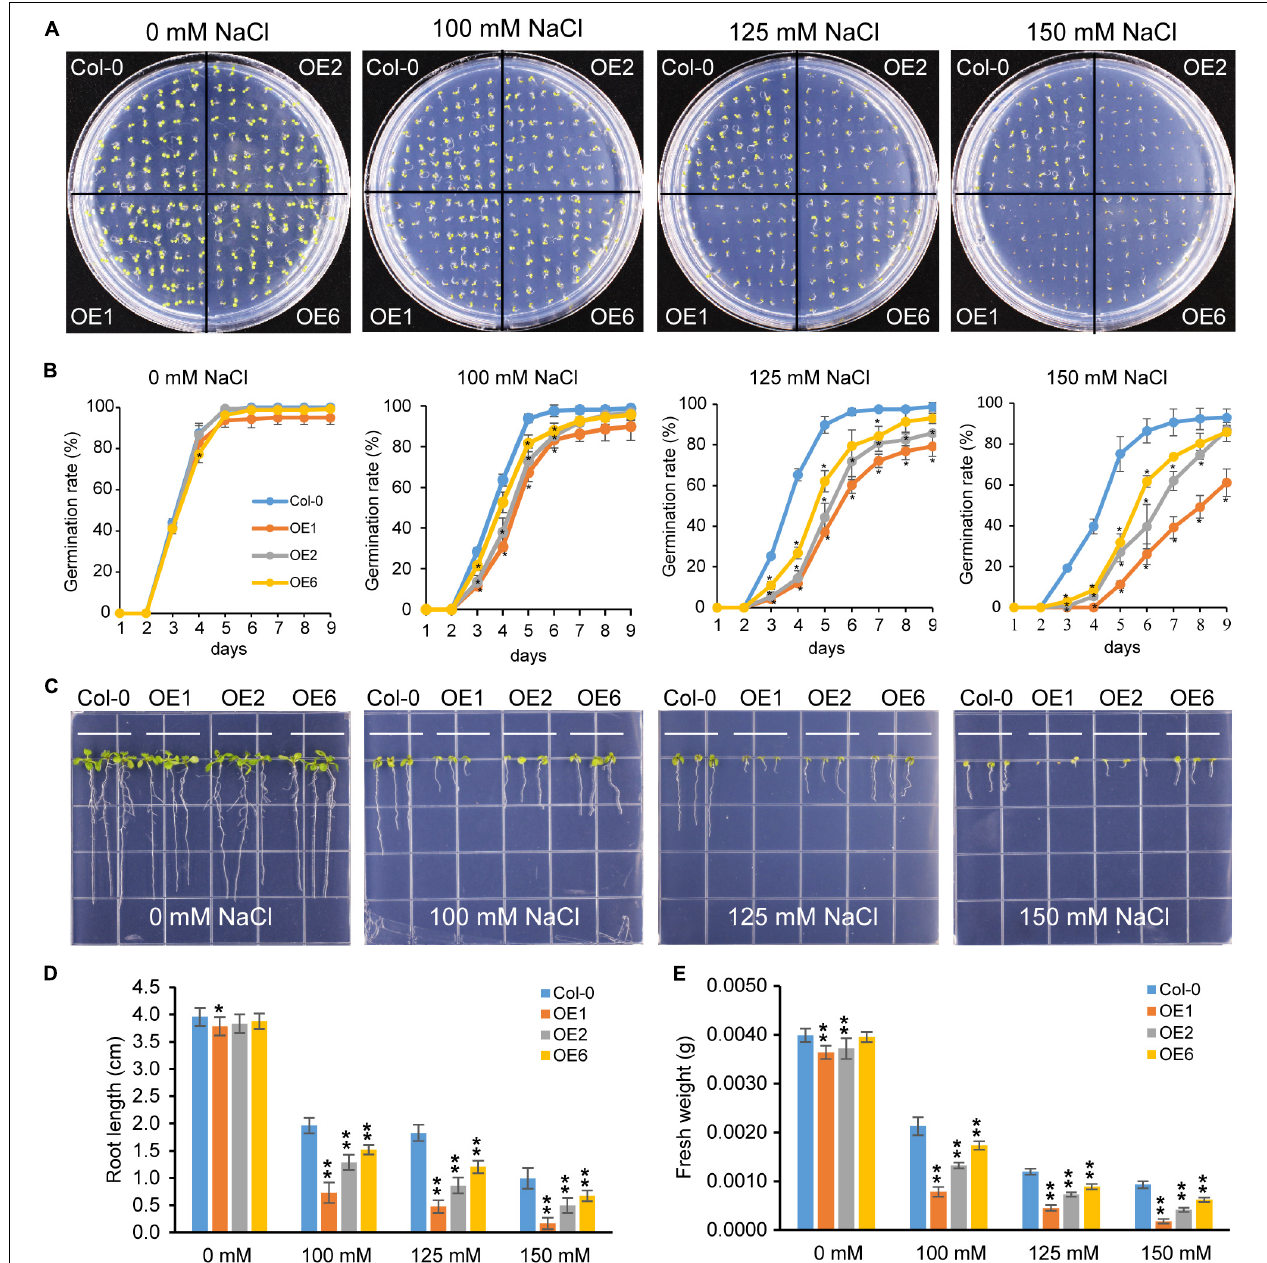
FIGURE 9 | Overexpression of PtrTCP10 increased salt sensitiveness. (A) Comparison of the seed germination phenotypes between 35S:: PtrTCP10 OE lines and wild-type (Col-0) under salt stresses with different concentrations of NaCl. (B) Germination rate of 35S:: PtrTCP10 OE lines and wild type under salt treatments. (C) Comparison of the salt tolerance between 35S:: PtrTCP10 OE lines and wild type under salt treatments with different concentrations of NaCl. (D,E) Comparison of root length (D) and fresh weight (E) between 35S:: PtrTCP10 OE lines and wild type under salt treatments. Error bars indicate the SD. Asterisks represent a significant difference between 35S:: PtrTCP10 OE lines and wild-type ( *p < 0.05, **p < 0.01; Student’s t -test).